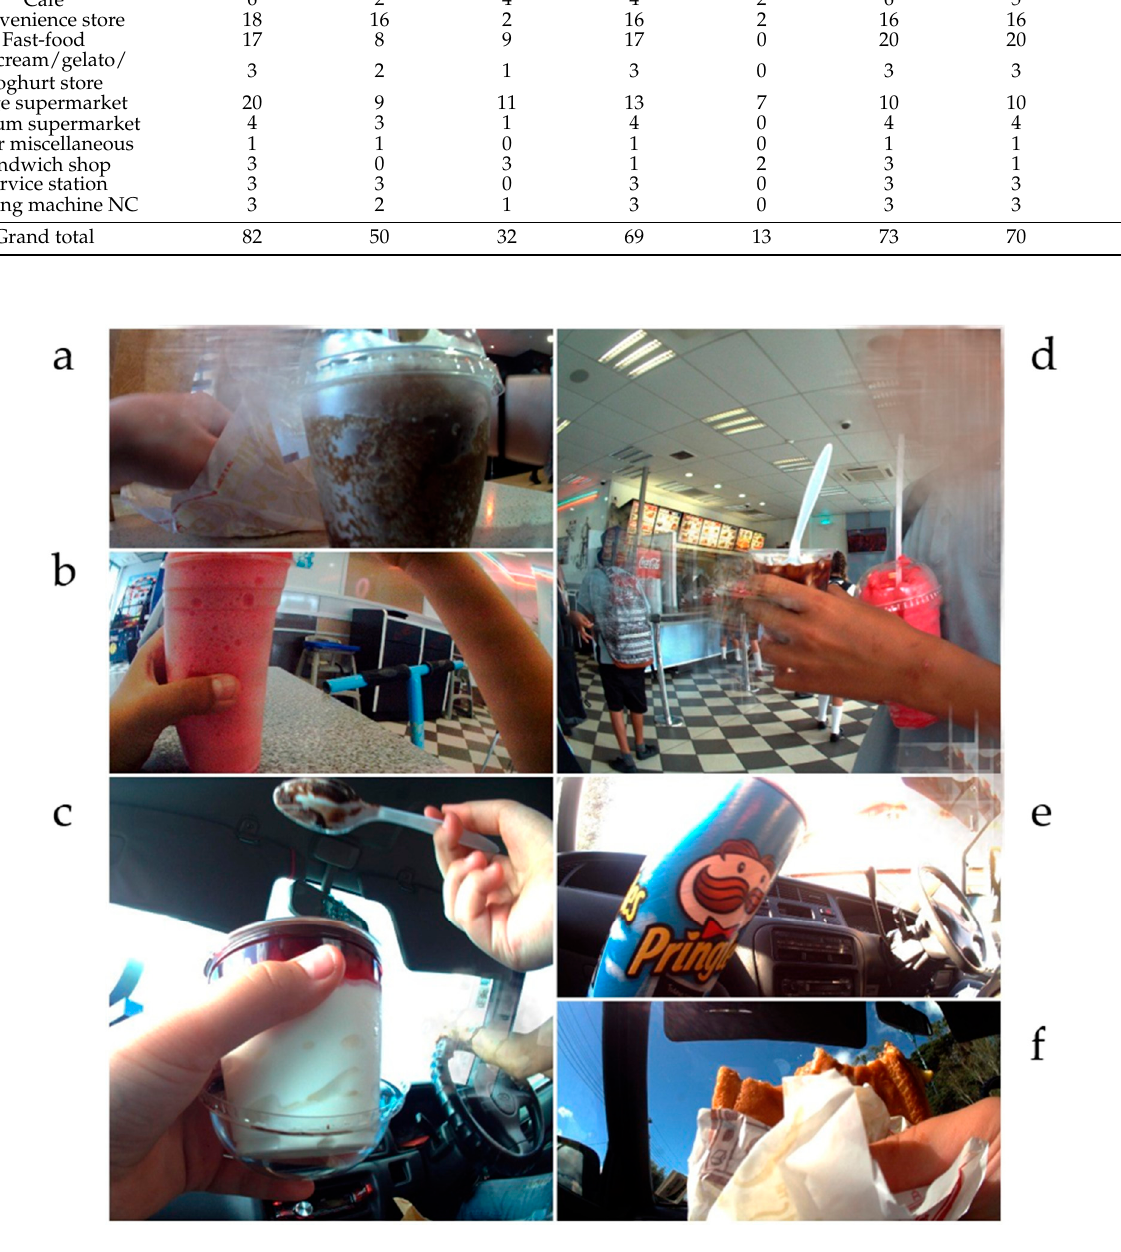
Figure 2. Purchase and consumption. ( a ) Frozen sugary drink at a fast-food outlet; ( b ) slushie at a fast-food outlet; ( c ) ice-cream sundae from fast-food outlet consumed while travelling in a car; ( d ) peer with frozen sugary drink and slushie at a fast-food outlet; ( e ) potato crisps purchased at a convenience store, consumed in a car; ( f ) hamburger from fast-food outlet consumed while travelling in a car.